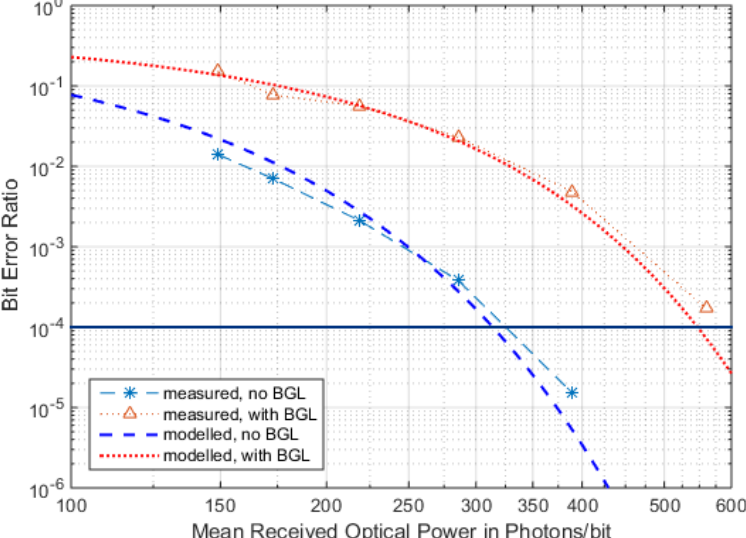
Figure 15. Measured BER performance with and without BGL for M opt ( i n = 2.5 pA/Hz 0.5 , I dm = 9 nW, P BGL = 50 nW, B = 500 MHz, r = 300 Mbps).